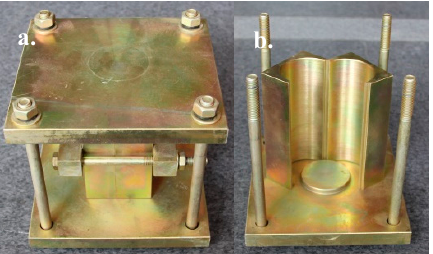
Figure 1. Device for cemented paste backfill (CPB) specimen production. Closed state ( a ); Open state ( b ).